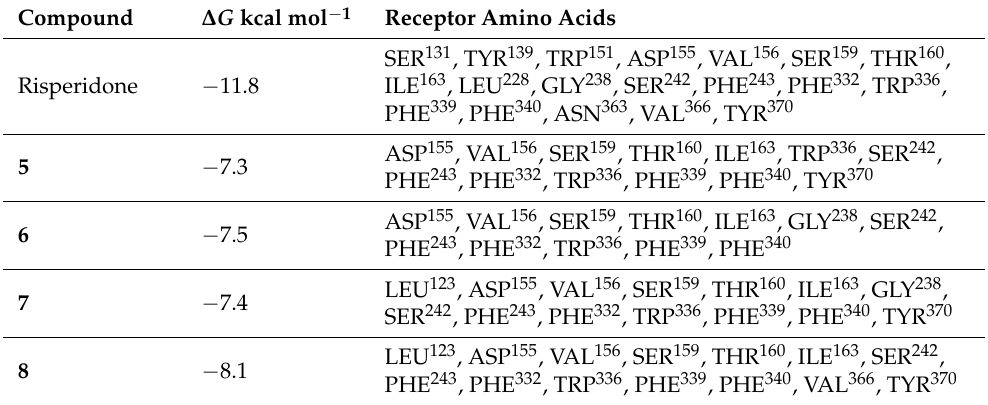
Table 4. Molecular docking parameters for the interaction of isolated SI indole compounds ( 5 – 8 ) with 5-HT 2A serotonin